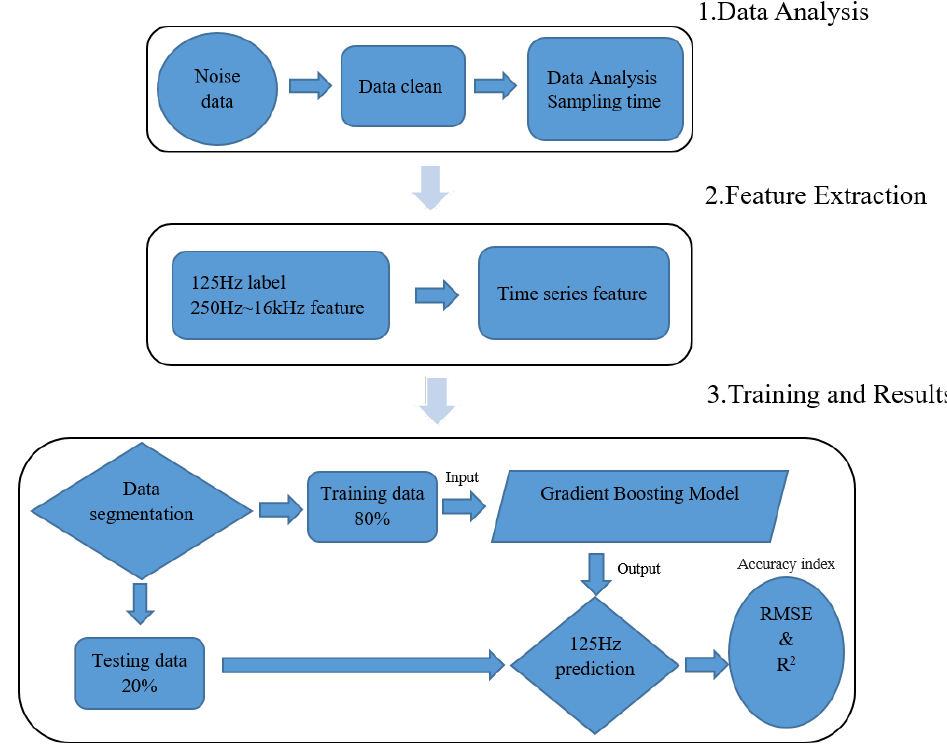
Figure 1. The main process of the method in three parts.